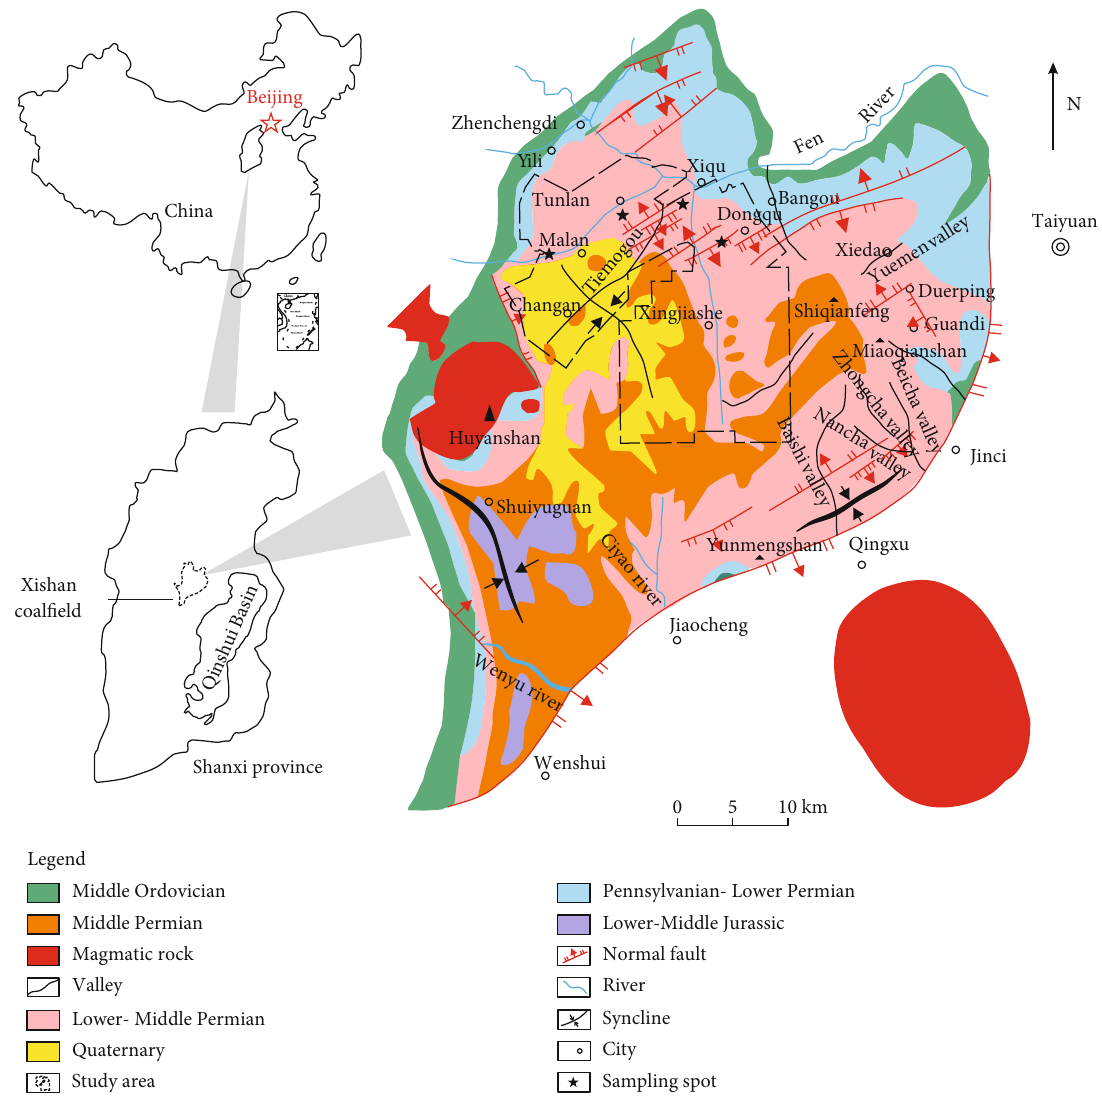
Figure 1: Location of the study area and structural outline of Xishan coal fi